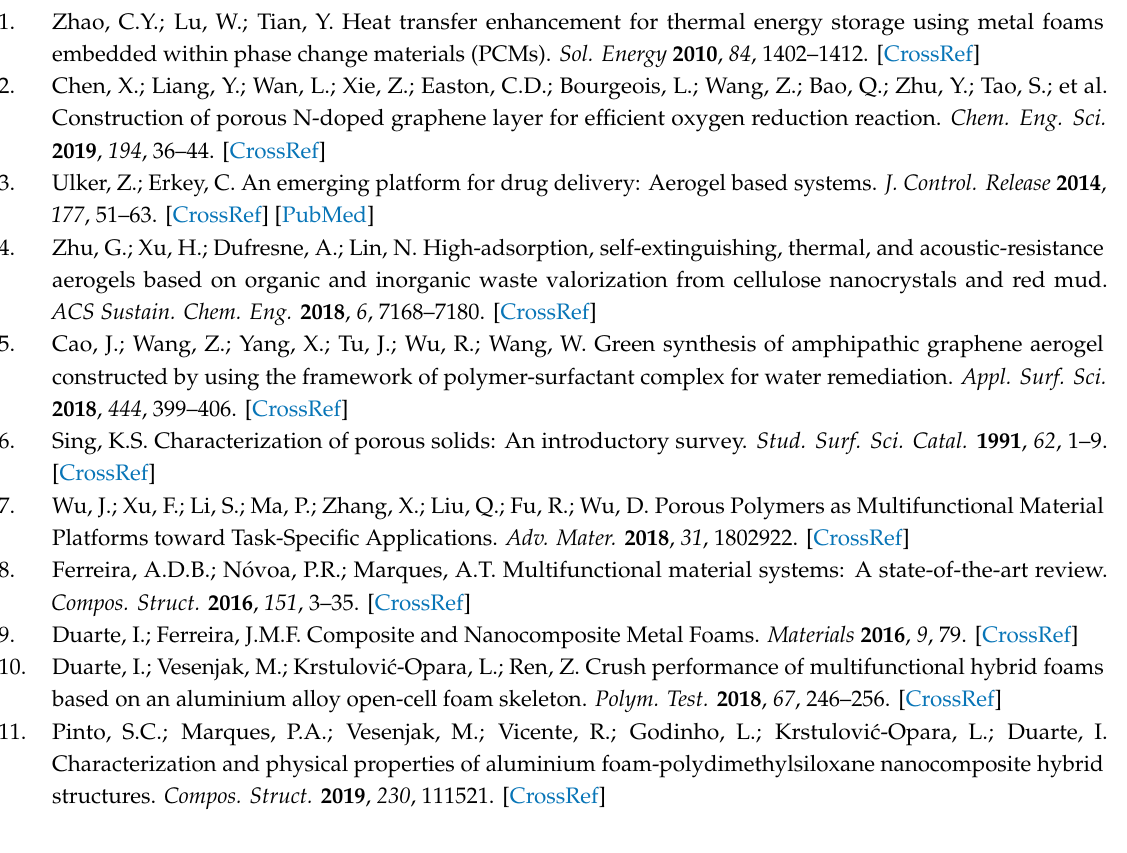
Figure S1: Normalized FT-IR spectra of MDI, Polyol, PUF, PUF / GNPs2.5 and PUF / GO2.5; Figure S2: Flame response of PUF / GNPs1.0 and PUF / GO1.0; Figure S3: (a) Thermogravimetric (TG) and (b) derivative thermogravimetric (DTG) curves of PUF with di ff erent graphene based materials (GNPs and GO) additives under oxidative atmosphere; Figure S4: (a) EAD and (b) SEA curves of Al-OC; PUF / GNPs2.5 and PUF /